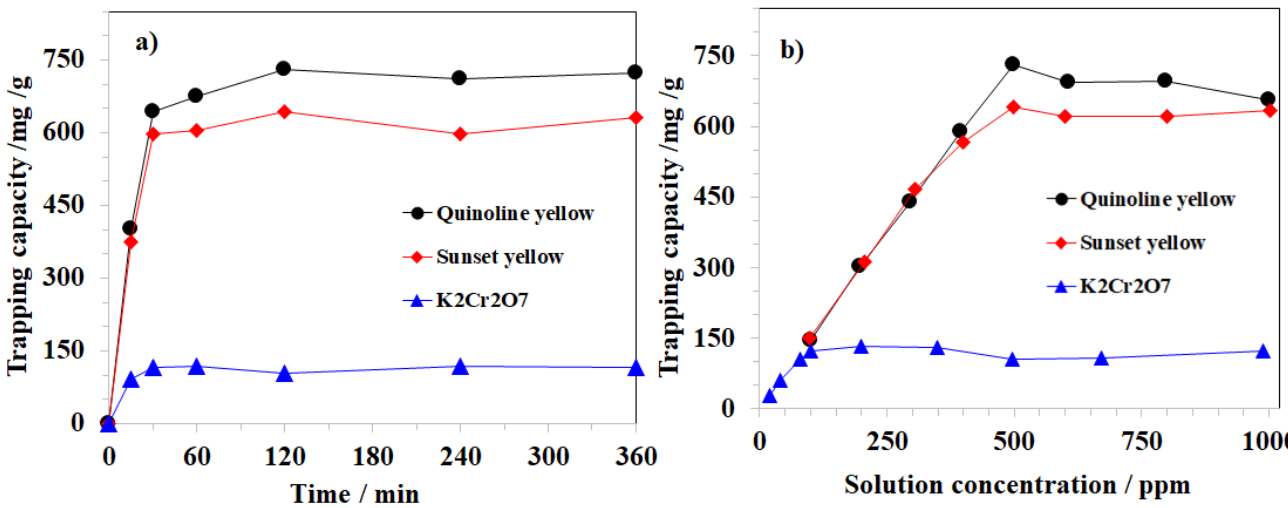
Figure 8. Effect of adsorption time ( a ) and solution concentration ( b ) on K 2 Cr 2 O 7 , quinoline yellow, and sunset yellow trapping capacity of MOF-808_300.